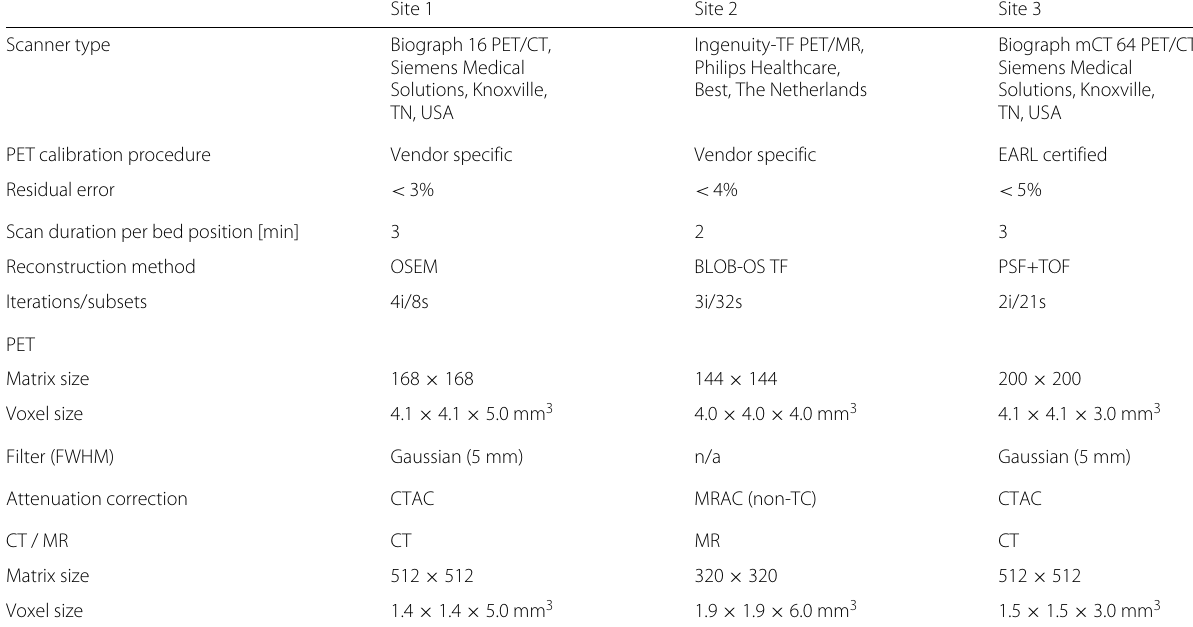
Table 1 Used PET systems and image reconstruction details